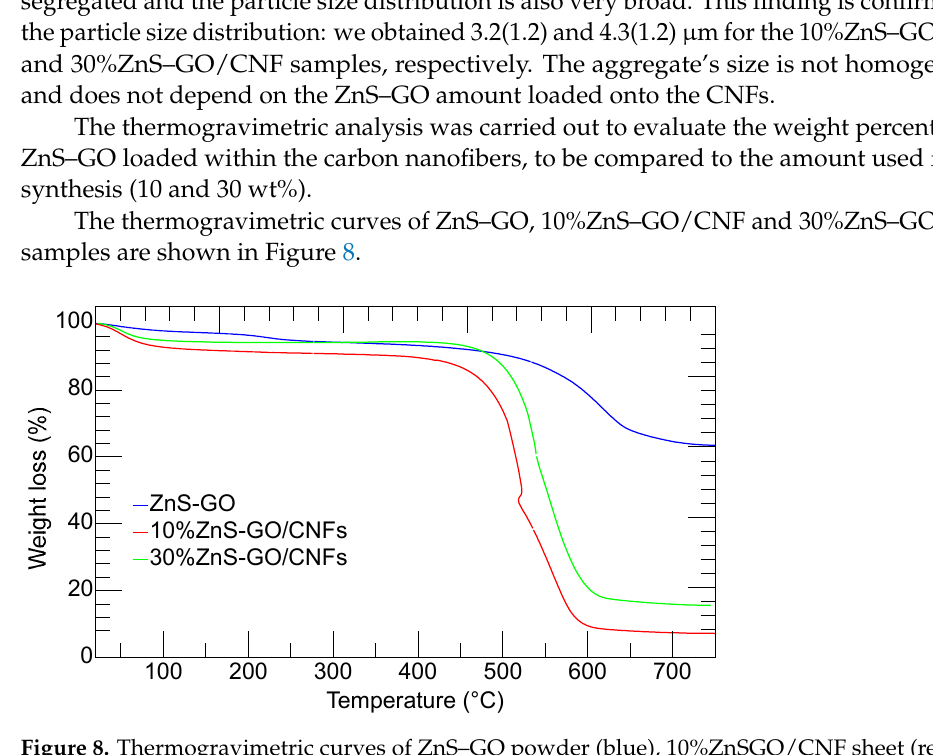
Figure 8. Thermogravimetric curves of ZnS–GO powder (blue), 10%ZnSGO/CNF sheet (red) and 30%ZnS–GO/CNF sheet (green).